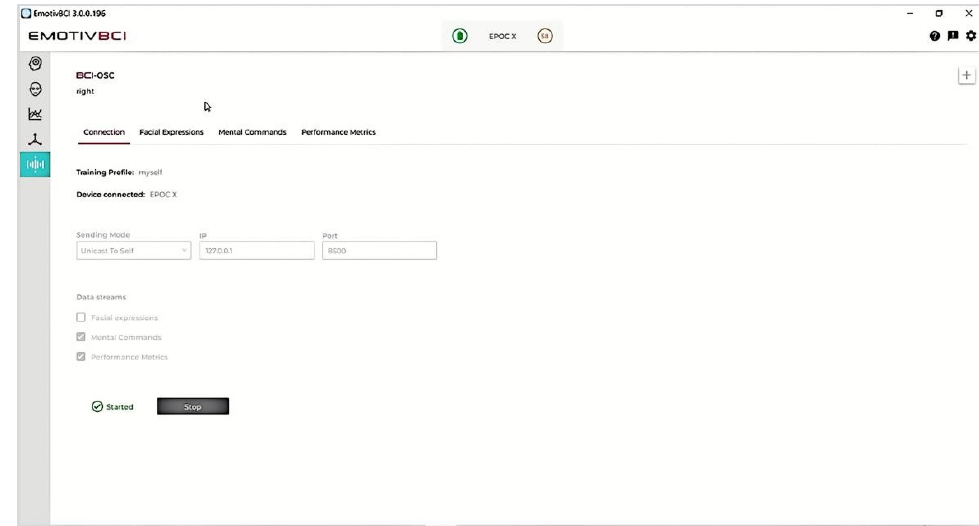
Figure 3. Consumer ‐ grade brain–computer device Emotiv Epoc X.